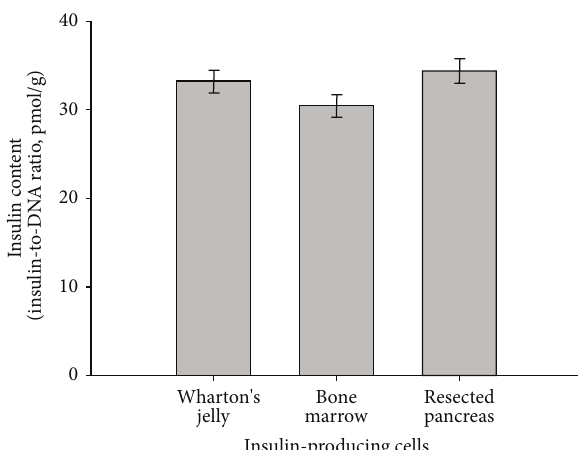
Figure 2: Insulin-to-DNA ratio in three different types of human tissue MSCs. Insulin-producing cells cultured in the maturation phase were stimulated as indicated and C-peptide in the medium was analyzed using ELISA. Measurements were normalized for DNA content of each sample. Three samples per condition were measured. Similar results were obtained in at least three independent